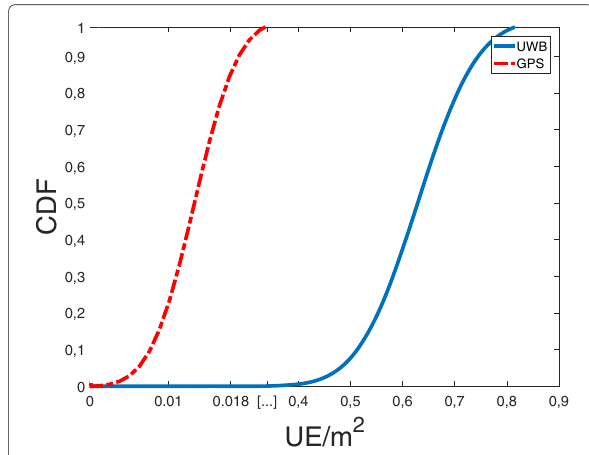
Fig. 16 CDF of the UE density per m 2 depending on the localization method. This figure represents the CDF of the UE density per square meter for the detected hotspots with both methods and we observe that UWB provide much more dense hotspots than GPS method